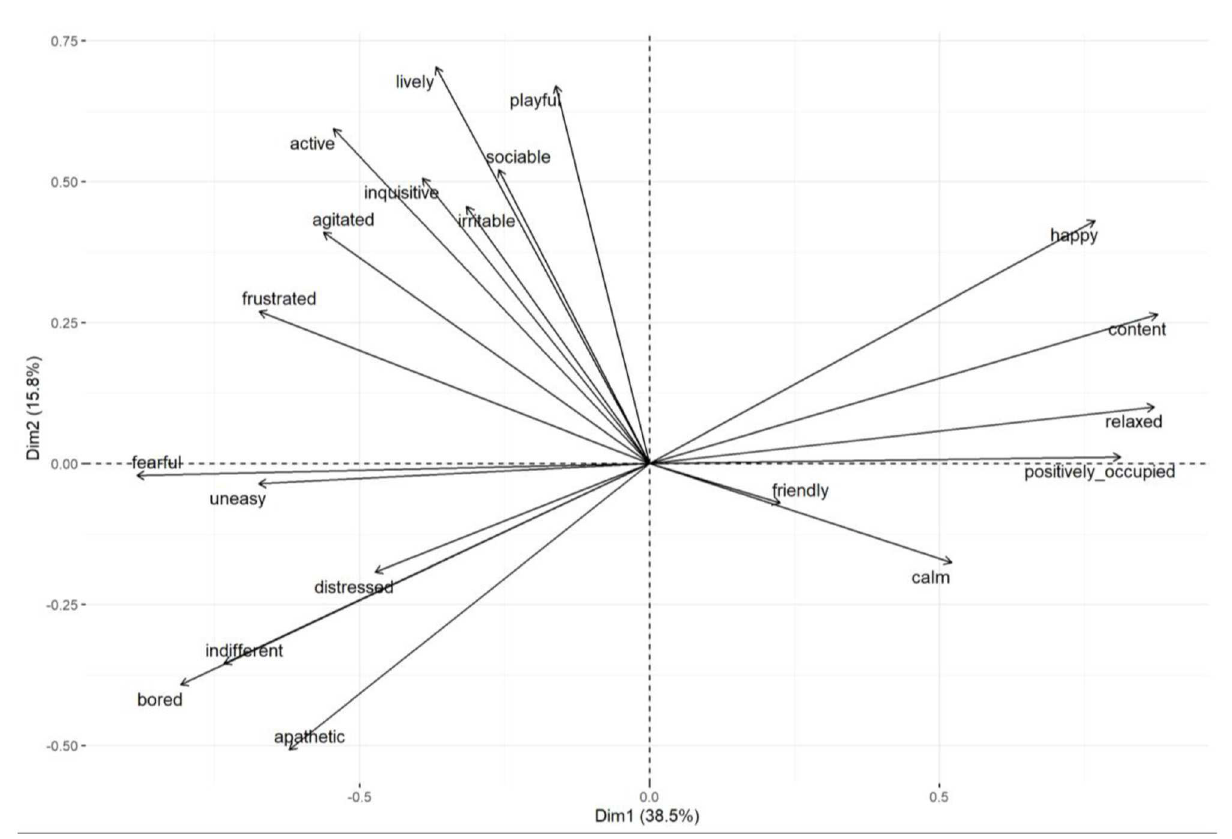
FIGURE4 Group 1: Variable correlation plot displaying the relationship between all variables in PC1 (Dim1) and PC2 (Dim2) and each terms value figure in contribution to the principal component.